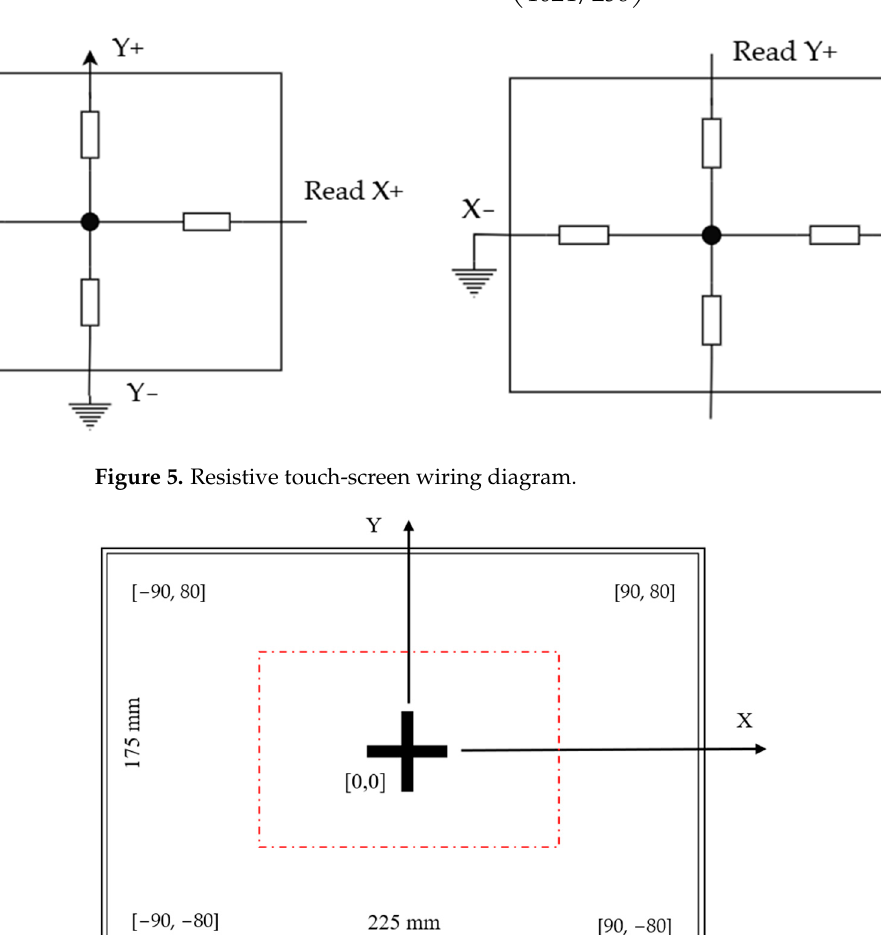
Figure 7. The ball diameter is R = 33.33 mm and the mass of the ball is m = 151 g.